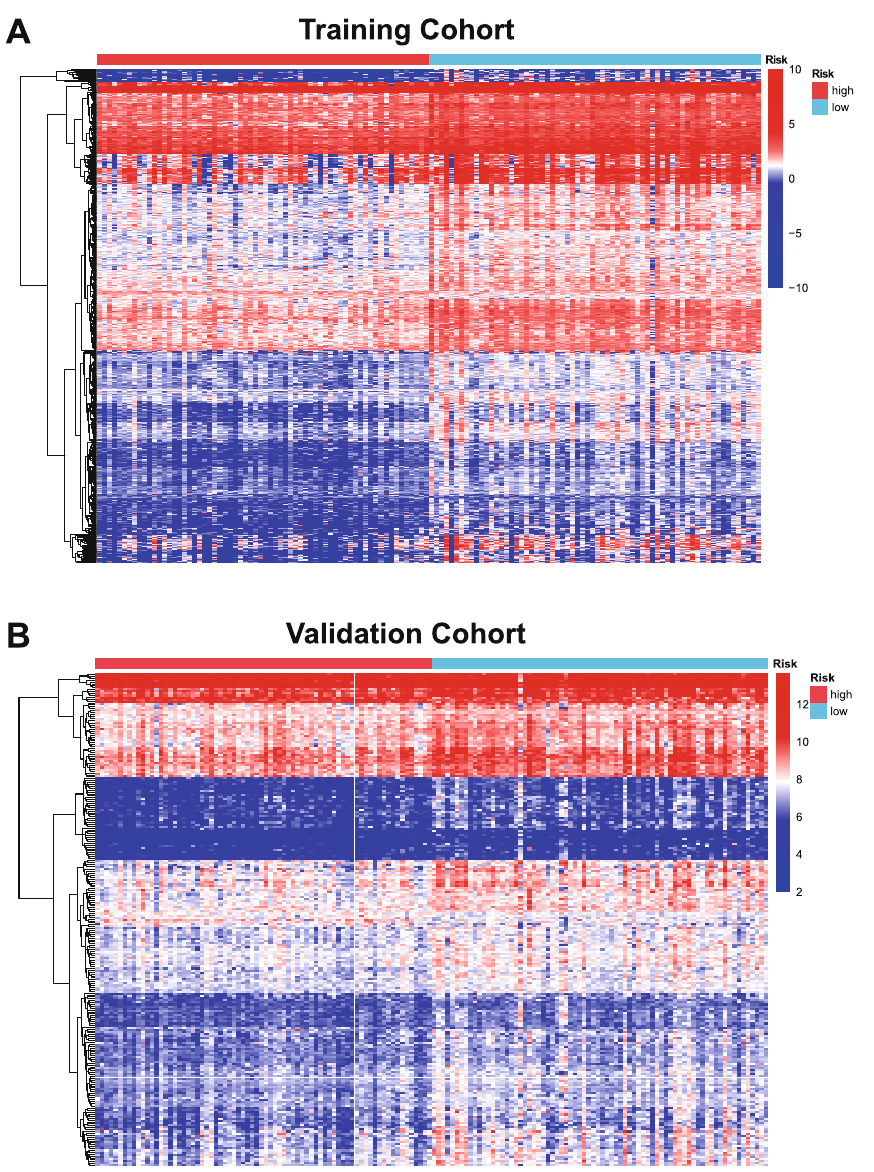
Figure 5. Differentially expressed genes in the training cohort and validation cohort. ( A ) Heatmap of differentially expressed genes between the high-risk score group and the low-risk score group in the training cohort. ( B ) Heatmap of differentially expressed genes between the high-risk score group and the low-risk score group in the validation